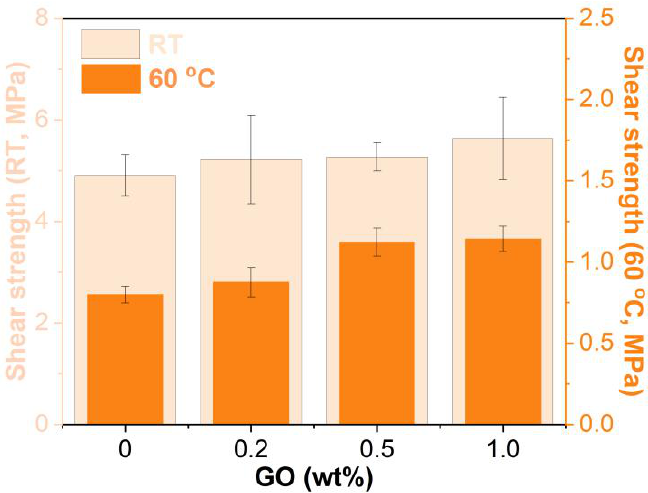
Figure 14. Shear strengths of the unmodified and GO-modified EABCs.